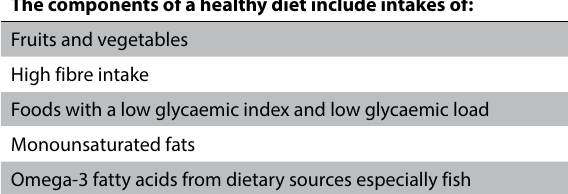
Table 3: Treatment options for overweight or obese patients 7 Treatment